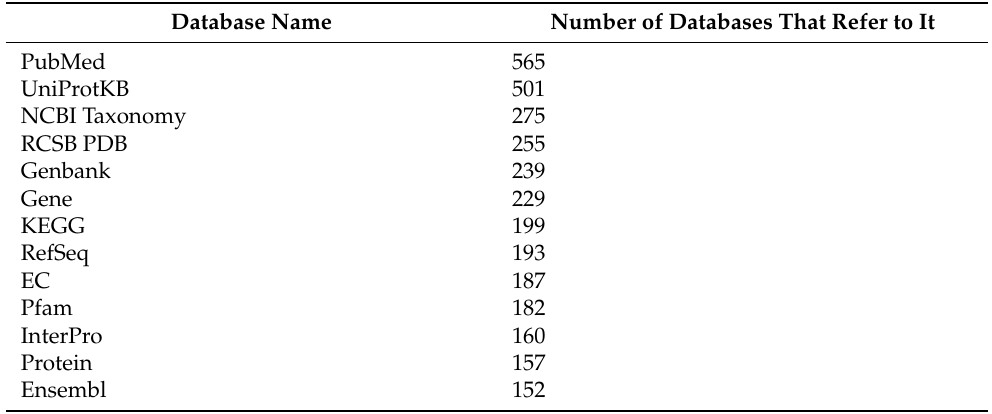
Table 3. The most popular